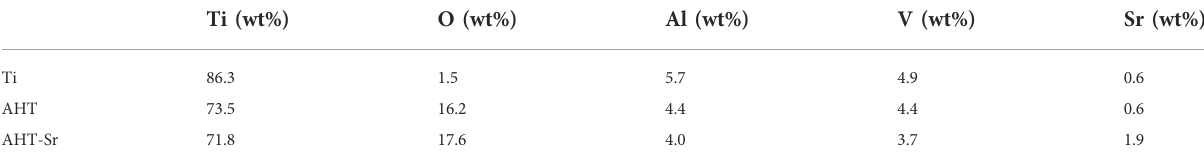
TABLE 2 Element contents on the surface of Ti, AHT, and AHT-Sr samples determined by EDS.